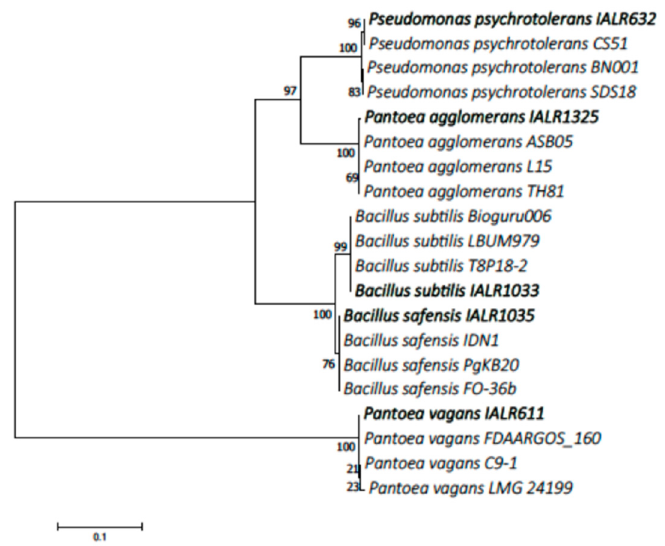
Figure 1. Phylogenetic tree for the phosphate solubilizing bacteria with GenBank references. The tree was constructed using neighbor-joining method with bootstrap support values derived from 1000 replications and shown as a percentage next to the branches. The bacterial strains used in this study were highlighted in bold. Table 2. The solubilization of different insoluble phosphate compounds by bacterial endophytes. Phosphate Compounds